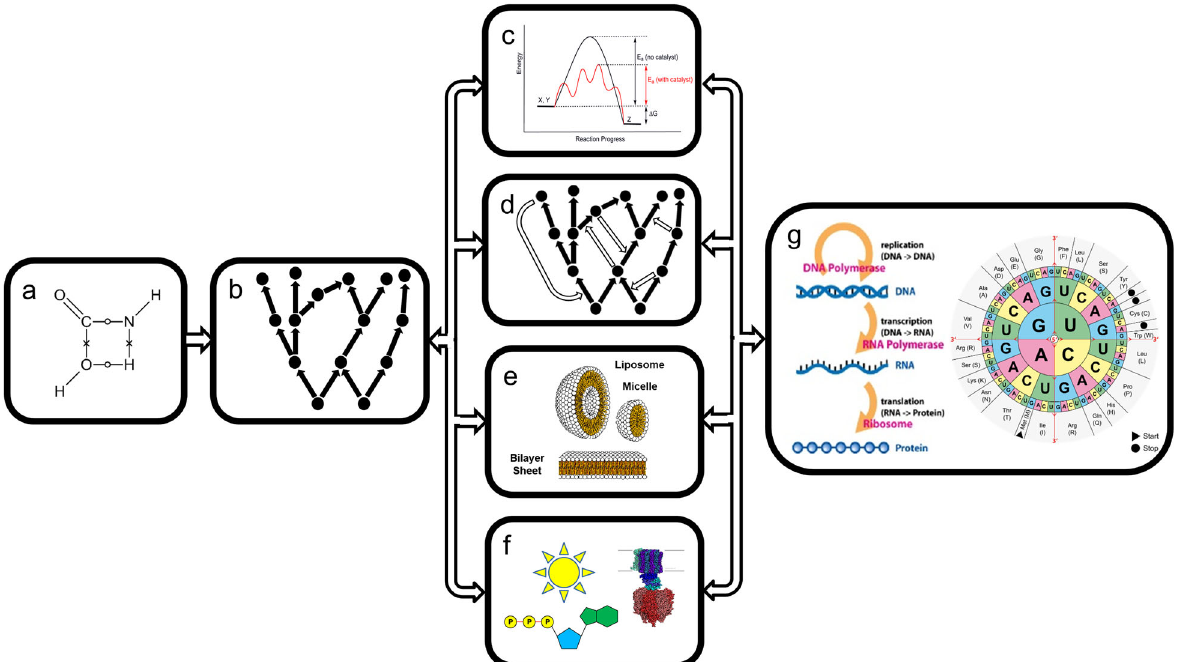
Fig. 1 Work fl ow for studies of the chemistry of life ’ s origins. Prebiotic reactions proceed according to mechanisms de fi ned by physical organic chemistry ( a ) to make complex product suites ( b ), as determined by kinetics and thermodynamics. Products of these simple networks may change the rules and restrictions of their generation causing the network to become more self-directed and life-like. Products may act as catalysts which lower energy barriers and enable the discovery of new chemistry ( c ) or steer the fl ux of compounds through certain preferred pathways which can become mutually reinforcing, leading to network closure ( d ). Products may also contribute to phase separation and another form of closure, encapsulation ( e ). Emergence of still more complex phenomena, such as activating chemistries and cellular capacitors, likely depend on multiple layers of network feedbacks ( f ). Finally the emergence of language-like processes may occur in a network with suf fi cient control to decouple structure and function ( g ). Feedbacks giving rise to such processes are presently hard to predict. Images are sourced as follows: Panel c: public domain licensing (https://commons.wikimedia.org/wiki/File: CatalysisScheme.png); Panel e : public domain licensing (https://commons.wikimedia.org/wiki/File:Phospholipids_aqueous_solution_structures.svg);